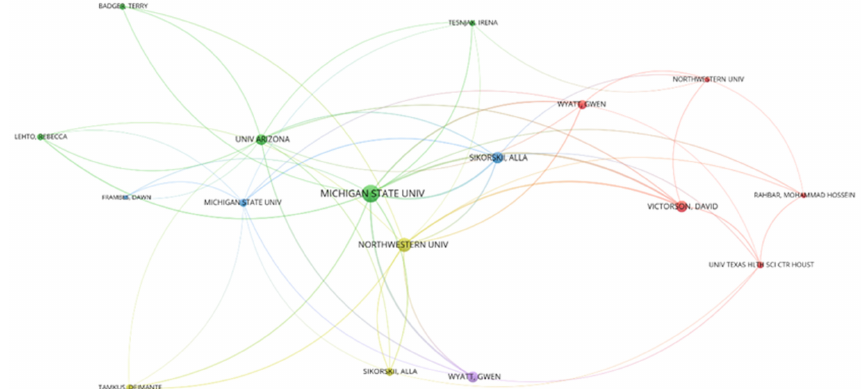
Figure 6. The collaborative network of prolific authors and research institutions in the field of foot reflexology research between 1991 and 2021.